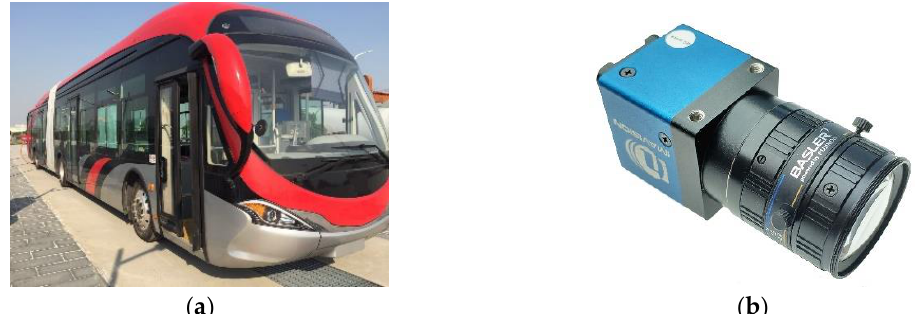
Figure 6. Experiment Platform: ( a ) 18 m testing bus, ( b ) vehicle-mounted camera. Table 1. Parameters of the vehicle-mounted camera.